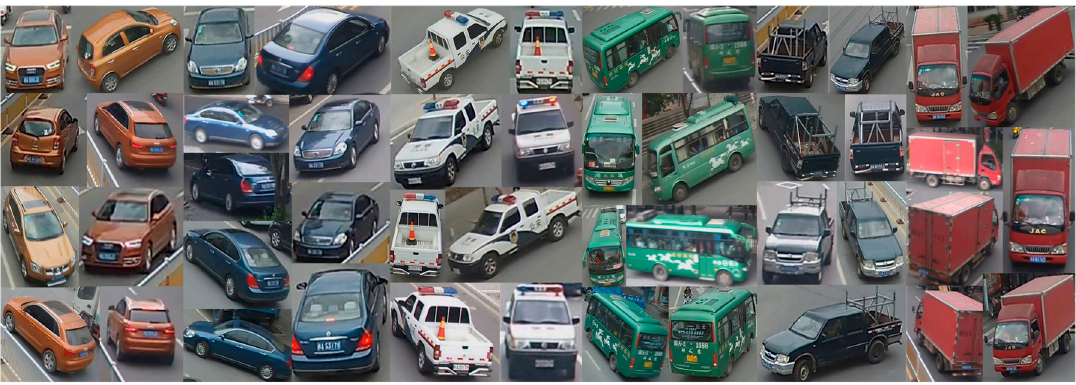
Figure 6. Sample images of VeRi dataset [20].